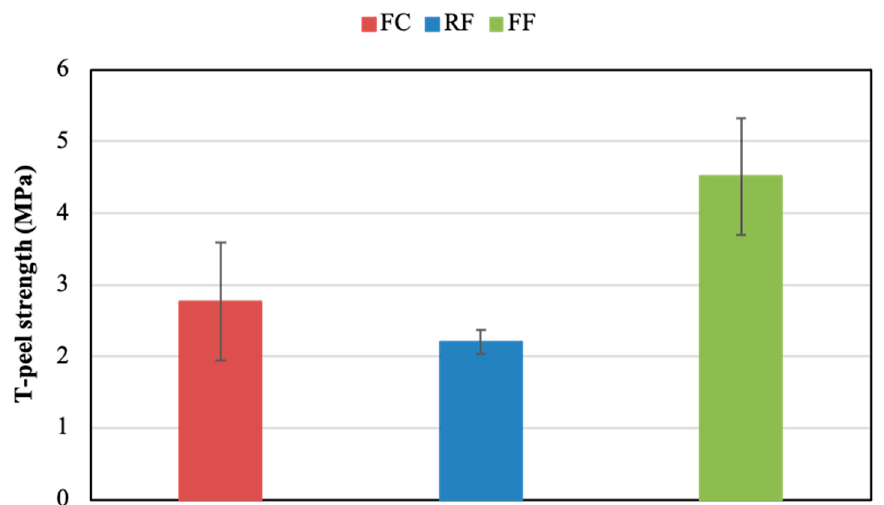
Figure 14. Characteristic T-peel stress–elongation curves of the 3 PSAs.